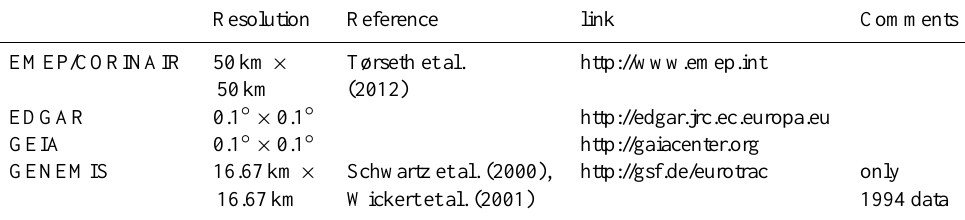
Table 2. Available emission inventories containing data on reactive nitrogen